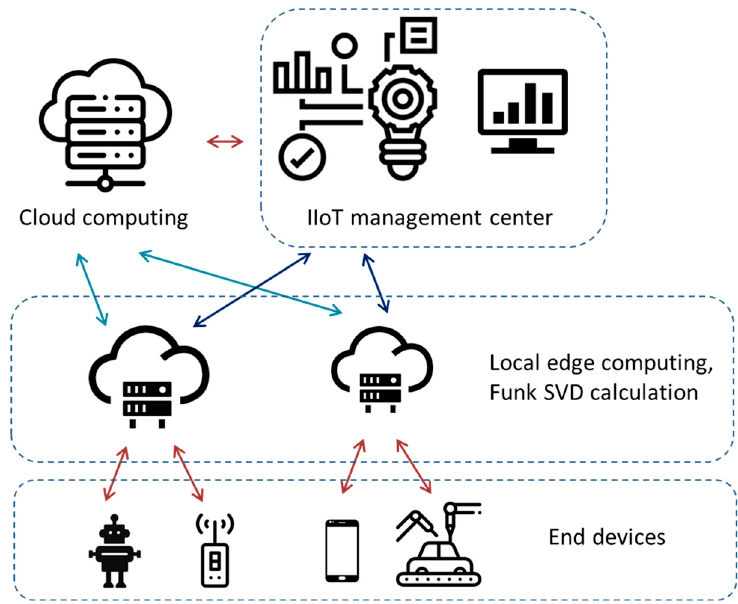
Figure 13. The architecture of the industrial recommendation system using Funk SVD.